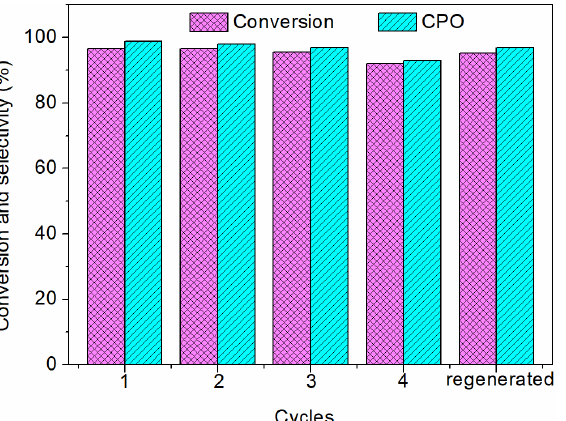
Figure 11. Recycling experiments of hydrogenative ring-rearrangement of FAL to CPO over Pd/UiO-66-NO 2 - 7 . Reaction conditions: catalyst (5.0 mg), FAL (100.0 mg), H 2 O (9.9 g), 150 °C, 1.0 MPa H 2 pressure, 5 h.